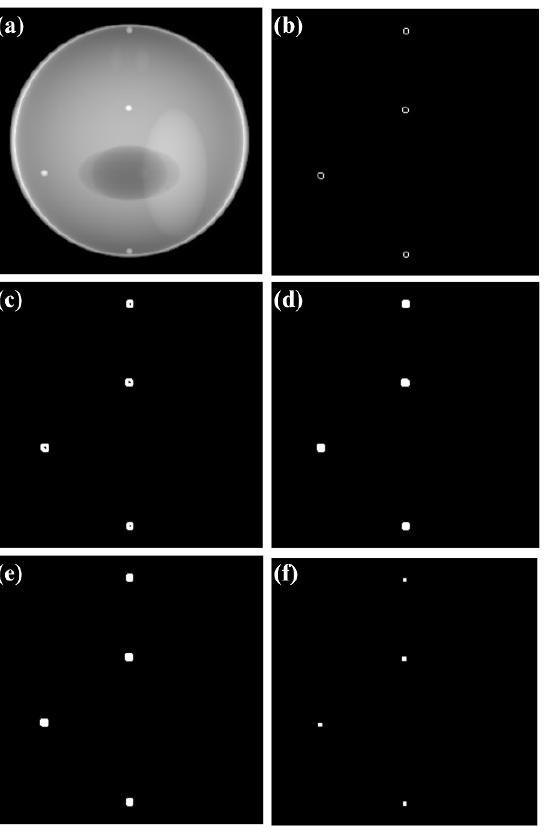
Figure 16. Finding coordinates of markers projection (a) X-ray pro- jection of the phantom with markers; (b) binary gradient mask of markers projection; (c) dilated gradient mask; (d) binary image with filled holes; (e) cleared border im- age; (f) eroded segmented image.